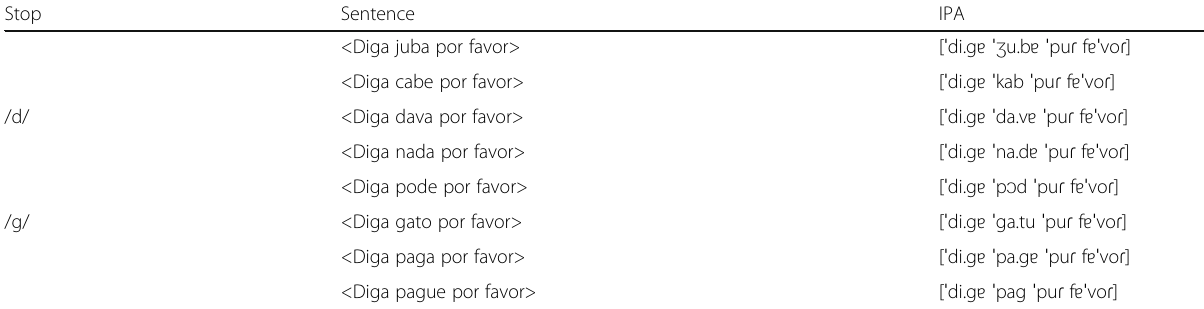
Table 15 Corpus of voiced stops: words in frame sentences